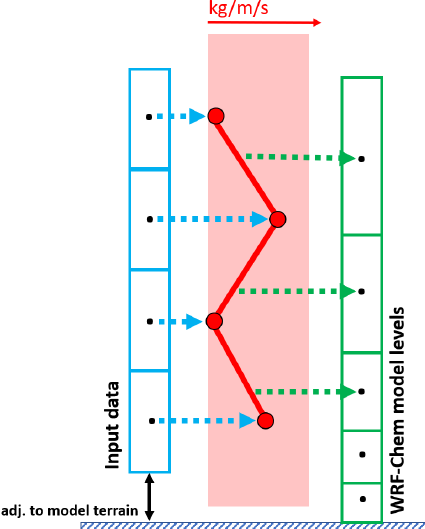
Figure 2. Linear interpolation between input data (blue) and WRF- Chem model levels (green) of the emission flux (red,